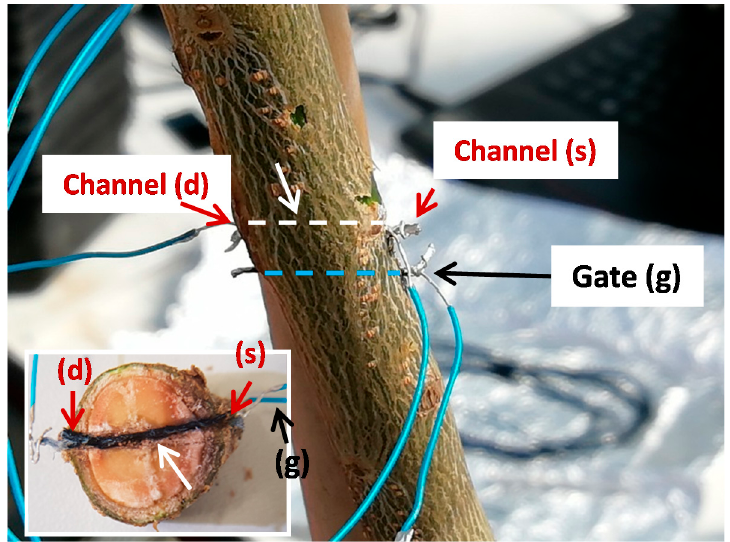
Figure 1. Side view of the olive tree trunk showing the setup of the bioristor with channel and gate wires which were connected to the multifunction I/O device for supply, record and store of electrical currents. In the inset: illustrative trunk cross sectional view (at the channel insertion point) showing the textile fiber functionalized with Pedot:PSS (white arrow).